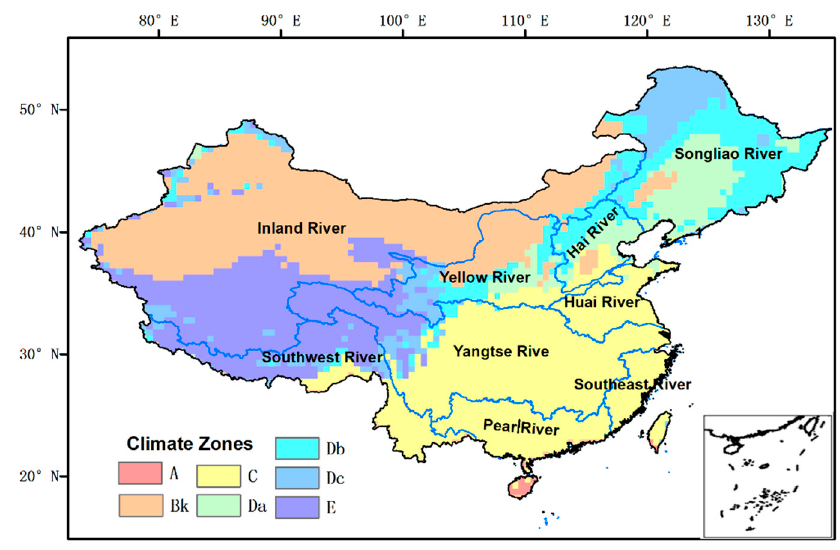
Figure 2. River basins and climate zones in China.